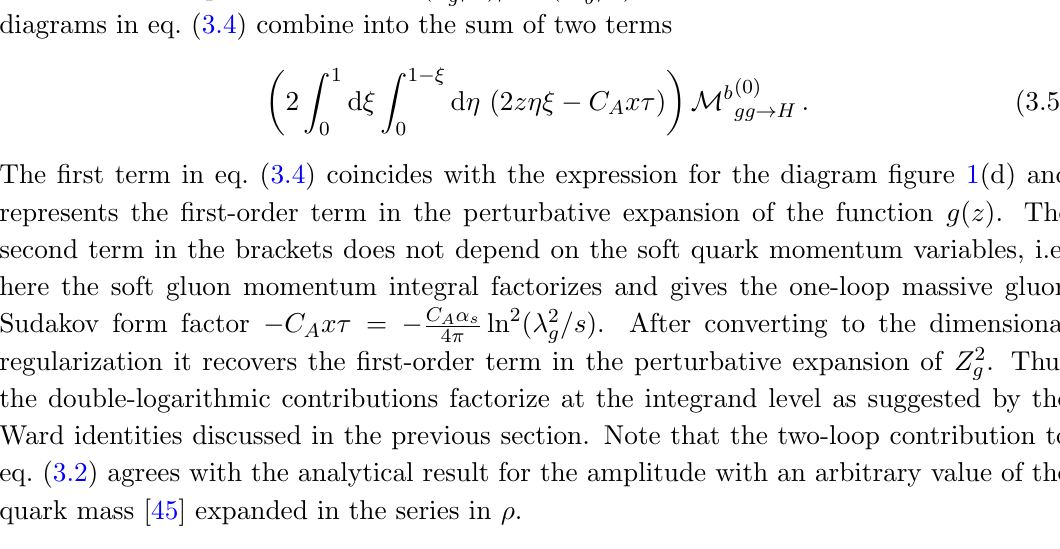
(cid:12)gure 5 and the corresponding contribution to the amplitude can be written in the form similar to eq.